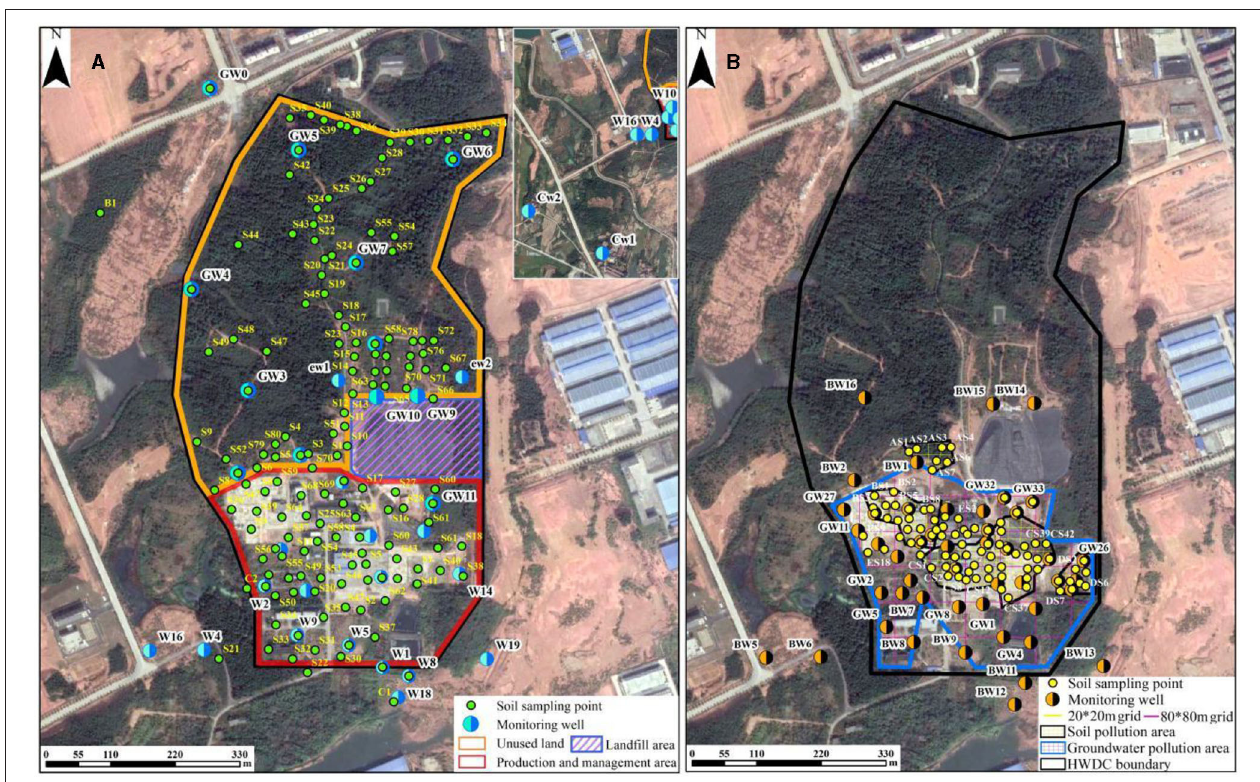
FIGURE 2 | Sampling points distribution in the preliminary survey (A) and detailed investigation (B)